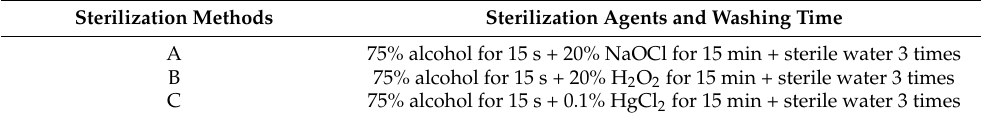
Table 1. Different methods for tuber